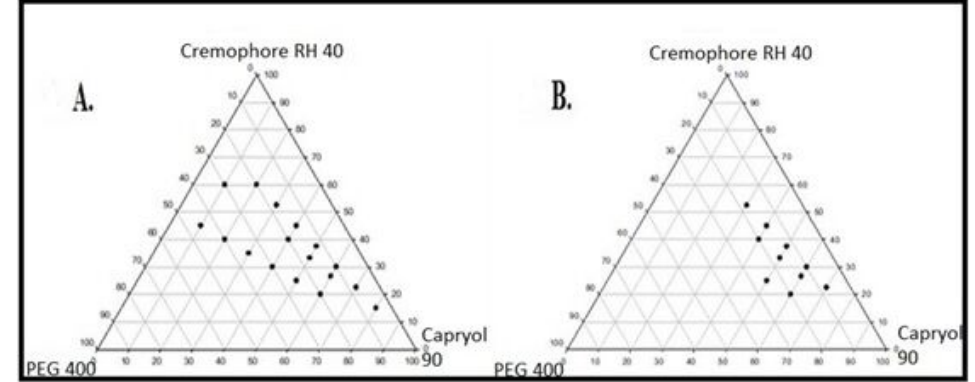
Figure 2. Pseudo ternary phase diagrams of SNEDDS ( A ) Blank formulations, ( B ) finasteride loaded formulations. Table 2. Physicochemical characterization of selected formulations. The results are shown as mean ± S.D.